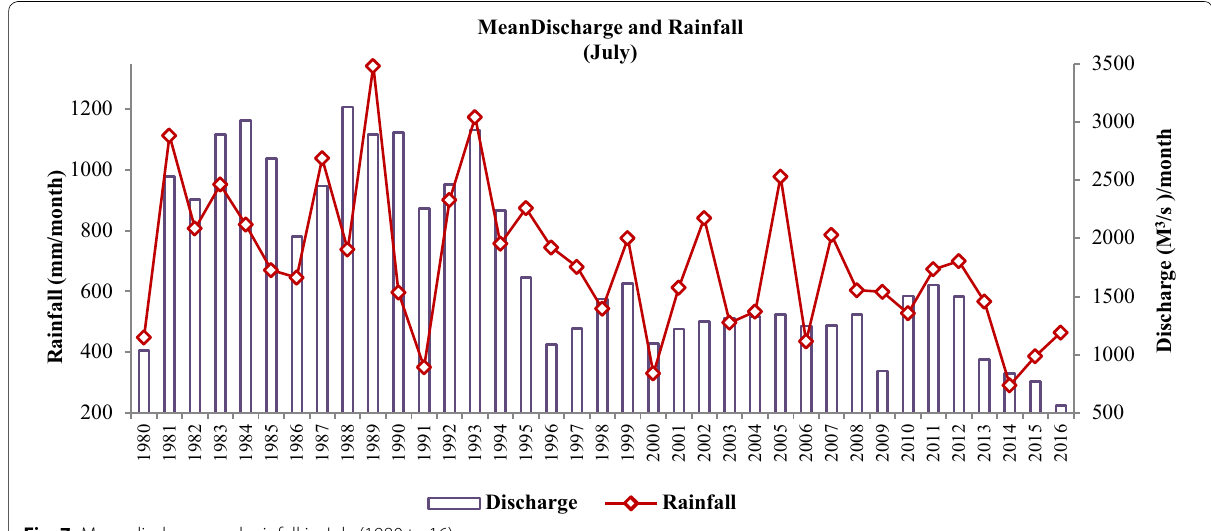
Fig. 7 Mean discharge and rainfall in July (1980 to 16)